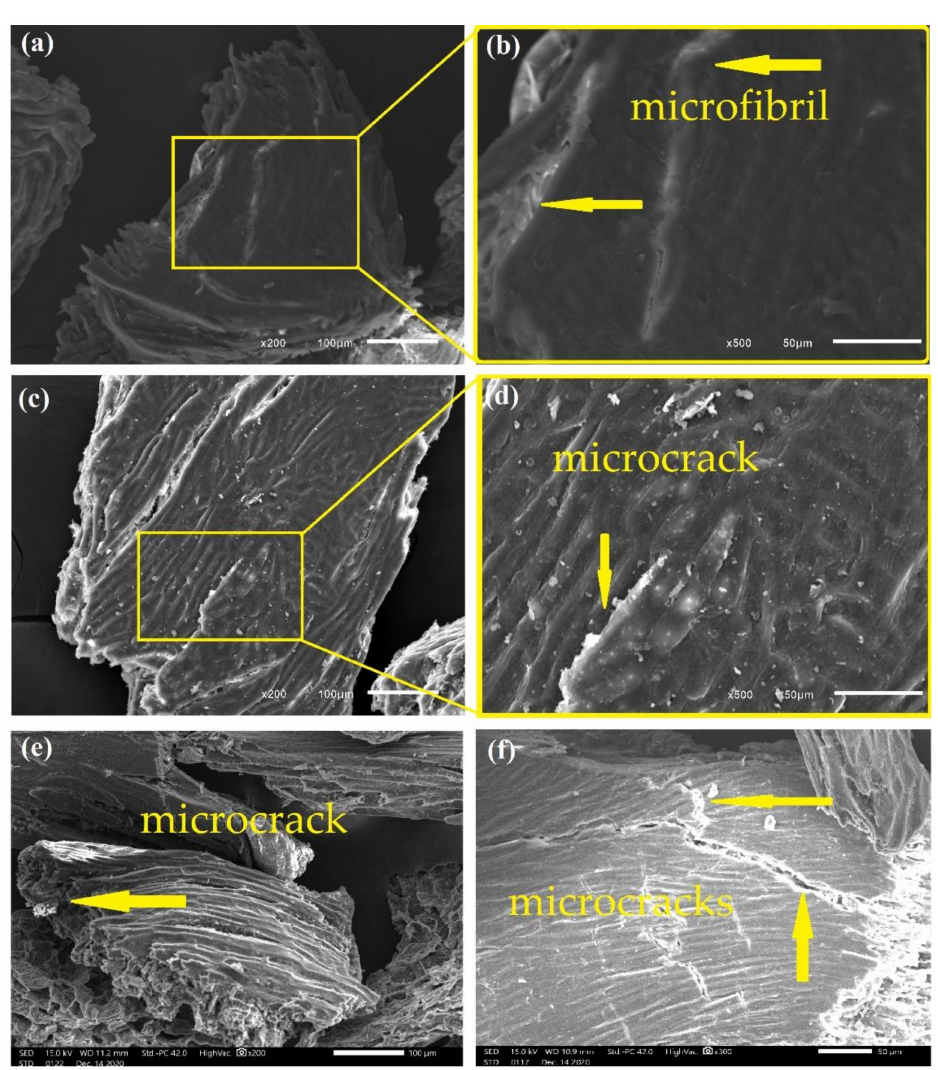
Figure 7. Photomicrographs of CHFW after HYD 30 ( a , b ); HYD 60 ( c , d ); and HYD 120 ( e , f )